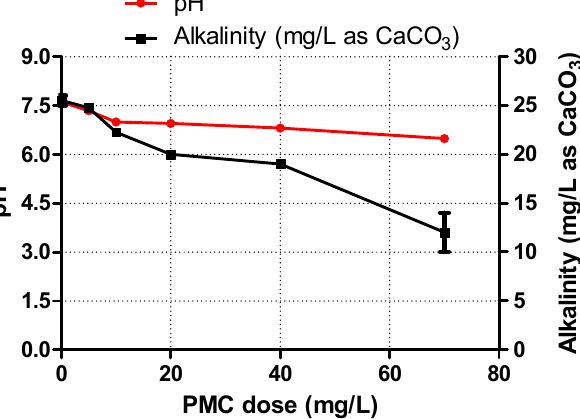
Figure 5. Effect of coagulant dose on pH and alkalinity with varying doses of the PMC coagulant (0, 5, 10, 20, 40, and 70 mg/L).